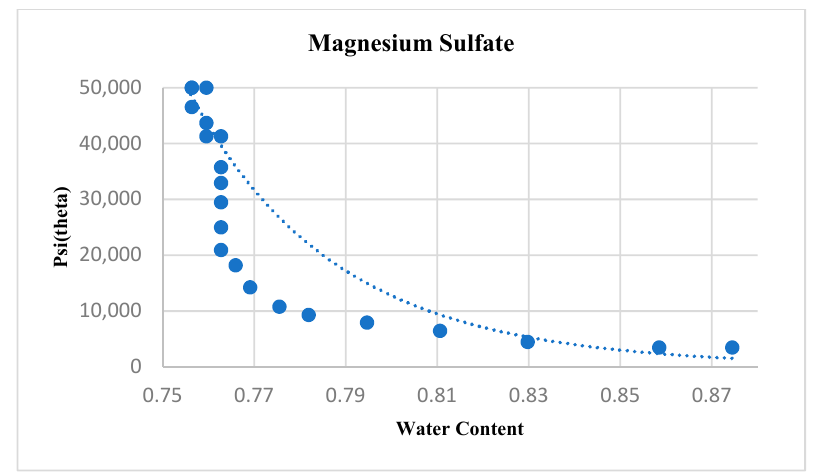
Figure 6. Decay model for magnesium sulfate.